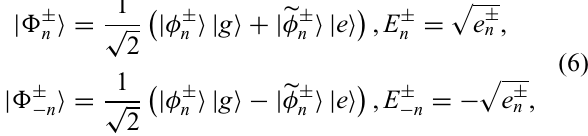
FIG. 4. (a) Energy spectrum of the TPE Hamiltonian separated in two branches of even (left) and odd (right) parity eigenstates. The zero-energy eigenspace is the cat-qubit manifold, gapped from the rest of the spectrum by an energy | E ± The spectrum is symmetric with respect to the zero-energy point. (b) Schematic of a combined TPE and two-photon dissipation confinement scheme. The cat-qubit resonator (blue) is coupled to both a low- Q buffer mode (green) and an anharmonic high- Q buffer mode (magenta) through an element that exchanges pairs of photons of the cat-qubit mode with single photons from either buffer mode.